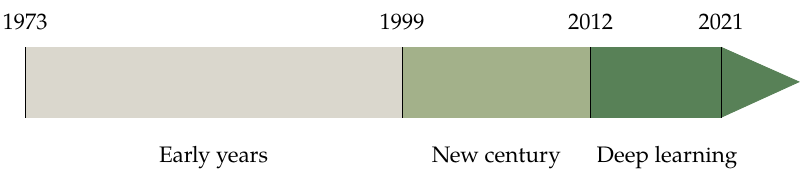
Figure 2. Colour and texture descriptors for visual recognition: overall periodisation.